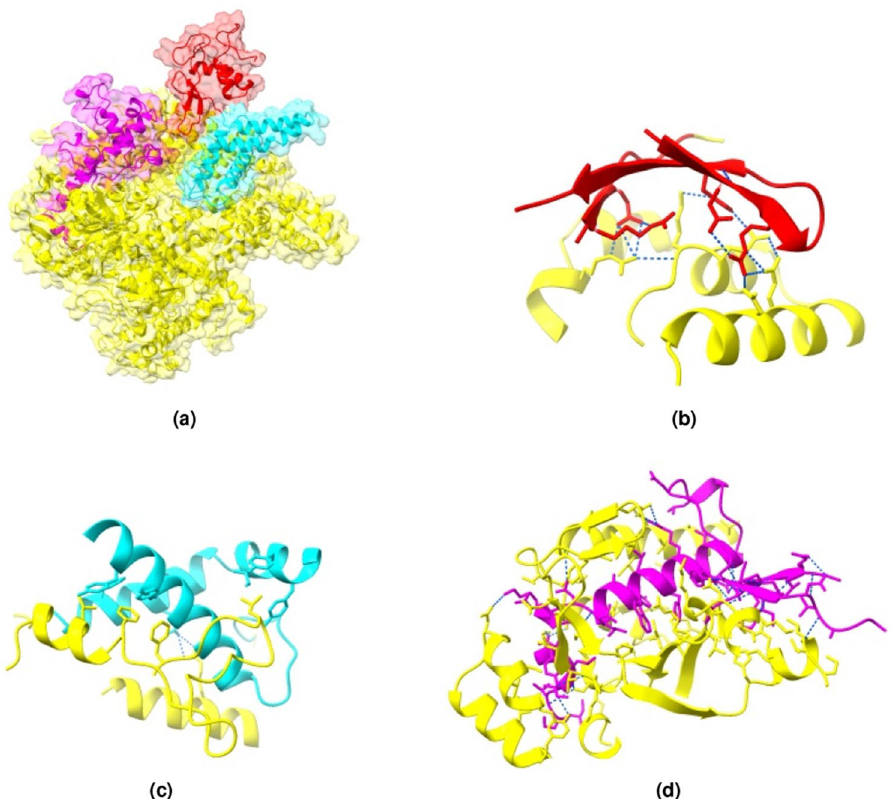
Figure 9. Three examples of apparent bias of EMA prediction, by the absence of molecular context. The figure presents the large (2225 residues) DNA-dependent RNA polymerase of crAss-like phage phi14:2 (PDB 6VR4) that gave rise to ten CASP14 targets: The whole protein (T1044), which was not offered as an EMA target, and nine domain targets T1031, T1033, T1035, T1037, T1039, T1040, T1041, T1042, and T1043. For six of them: T1031, T1033, T1035, T1039, T1040, and T1043, MESHI_consensus failed to provide reliable EMA predictions (LOSS above 0.16). We speculate that these failures may be attributed, at least partially, to the absence of the protein context in the isolated domains. ( a ) The three domain targets, depicted in the context of the whole protein (yellow): T1031 (residues 1–95, red), T1033 (residues 96–196, cyan), T1040 (residues 1372–1501, magenta). ( b–d ) The three interfaces of these domains (respectively) with the rest of the protein. A sample of the interacting residues is shown, the rest are hidden for clarity. Blue dashed lines represent hydrogen bonds and salt bridges (Figure is drawn with ChimeraX 68